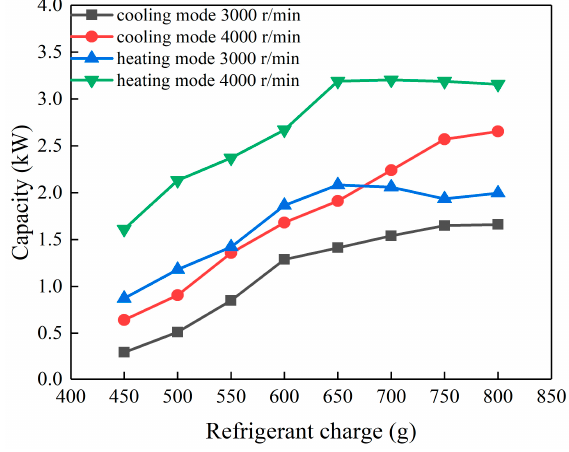
Figure 8. Capacity variations with refrigerant charge .